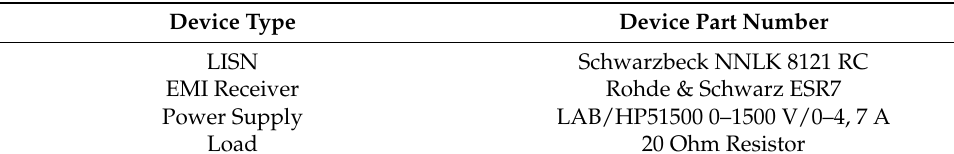
Figure 22. Test setup for conducted emission measurement. Table 1. Devices used for conducted emission measurement.